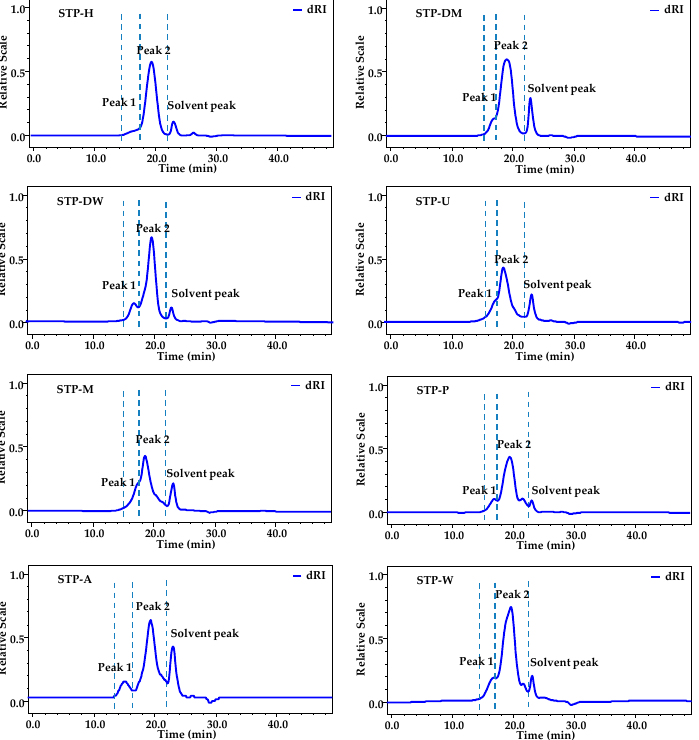
Figure 1. HPSEC chromatograms of STPs. STP-W, STP-M, STP-U, STP-P, STP-H, STP-DW, STP-DM, and STP-A indicate sweet tea polysaccharides extracted by hot water extraction, microwave-assisted extraction, ultrasound-microwave-assisted extraction, pressurized water extraction, high-speed shearing homogenization extraction, deep eutectic solvent-assisted extraction, deep eutectic solvent- microwave-assisted extraction, and alkali-assisted extraction,